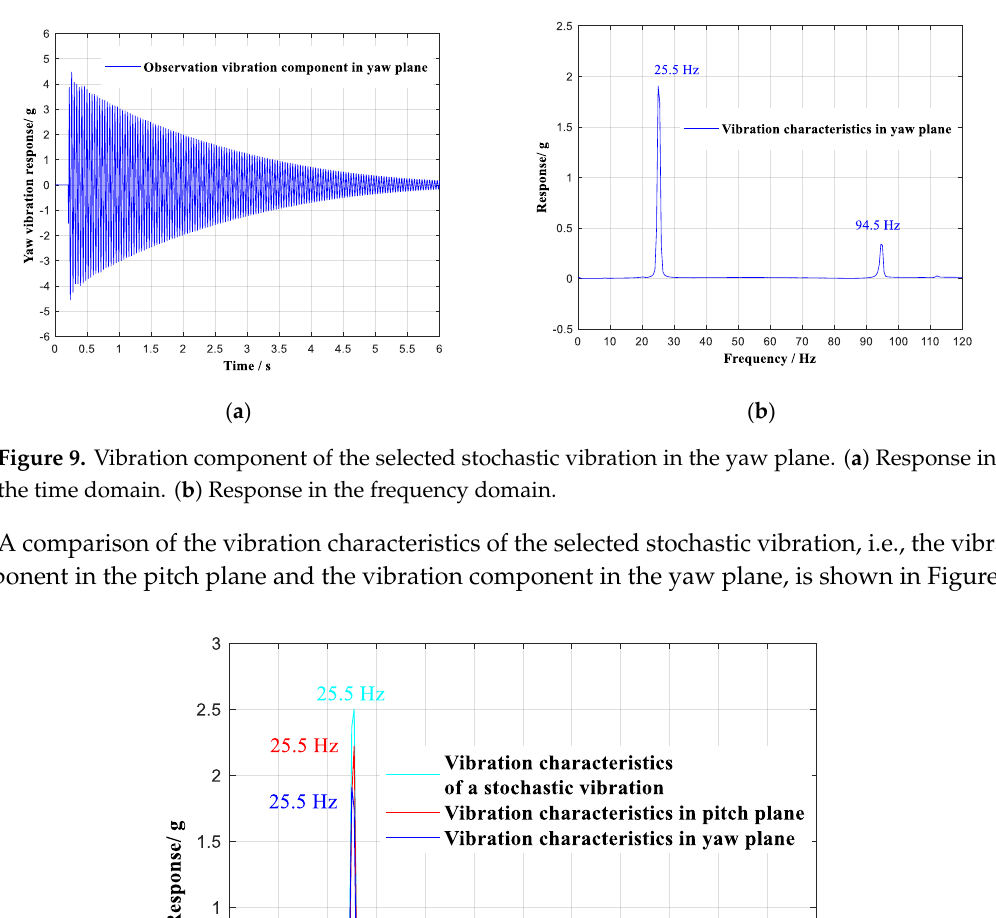
( b ) Figure 8. Vibration component of the selected stochastic vibration in the pitch plane. ( a ) Response in the time domain. ( b ) Response in the frequency domain.